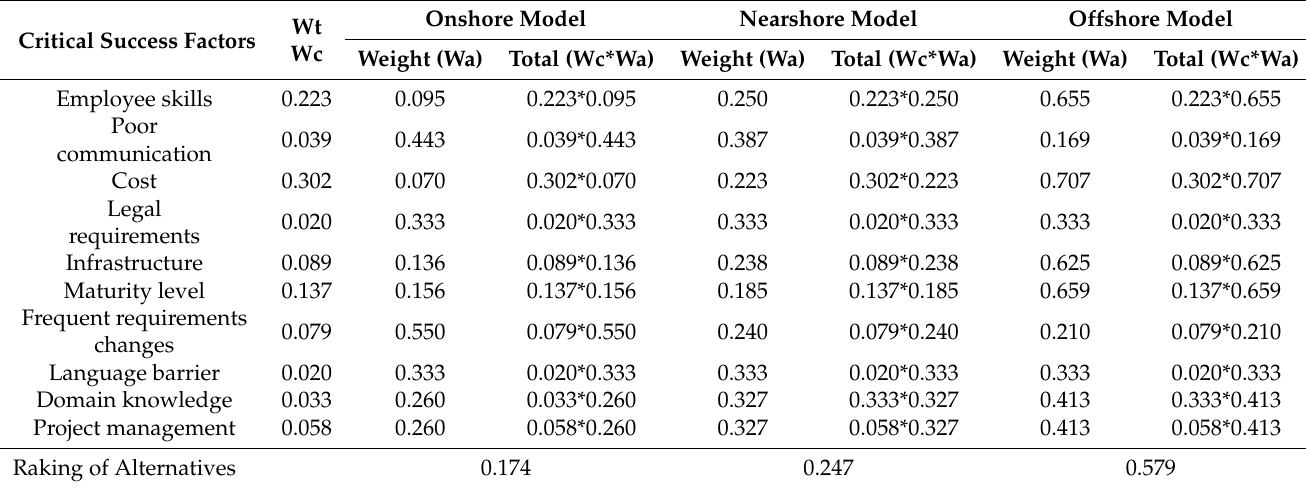
Table A7. Case study-2: Decision matrix.